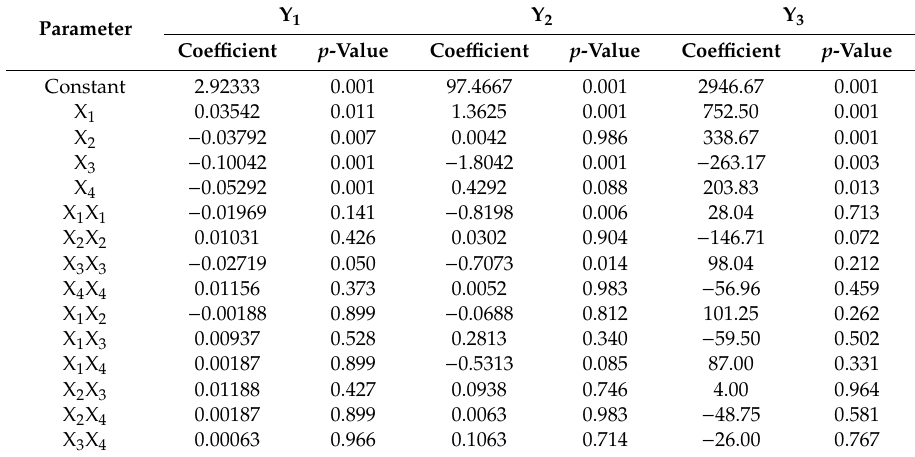
Table 3. The regression coe ffi cients of the fitted quadratic polynomial models for monitoring the e ff ects of preparation conditions on the physical